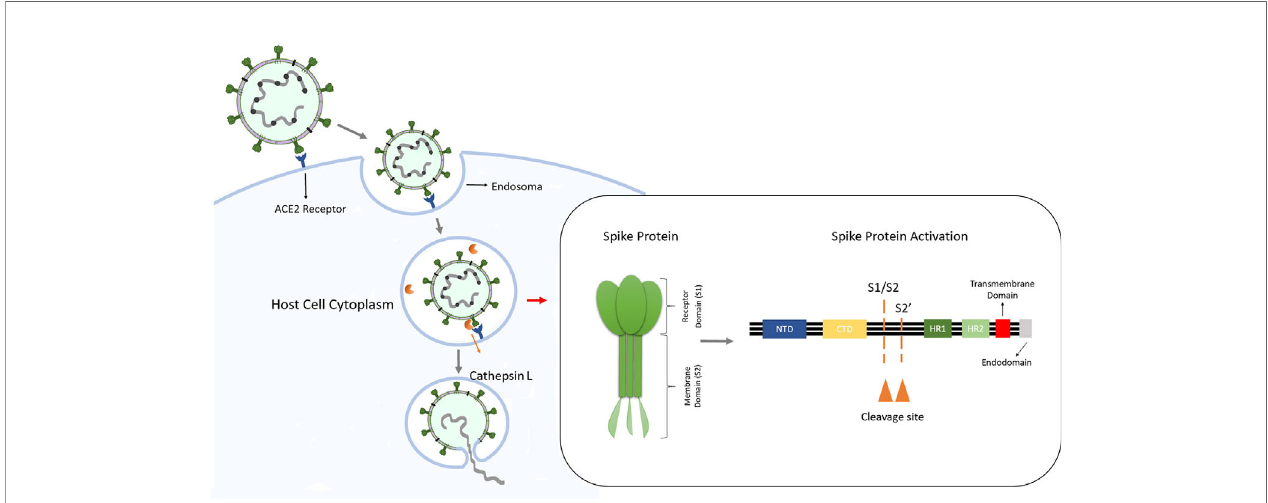
FIGURE 1 | SARS-Cov infection into target cells, entry via endosomes. After interaction with ACE2 in the host cell, the virus can entry into the cell via endosomes. The spike protein is formed by subunits 1 and 2 and has two functions: fi rst the S1 binds to ACE2 at the cell membrane followed by the S2 mediation of the fusion between Sars-Cov-2 and the endosome membrane, releasing the viral genome into the host cell. The fusion occurs after spike protein activation by host protease cathepsin L through the cleavage of S1/S2 border and the S2 ’ s